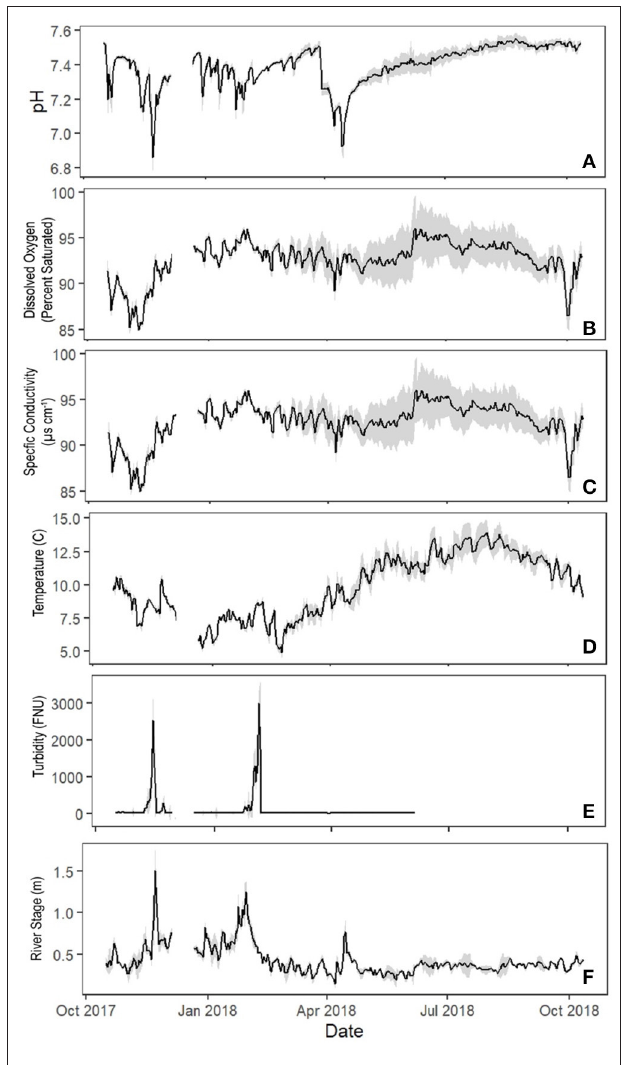
FIGURE 3 | Time series of (A) pH, (B) dissolved oxygen (percent saturated), (C) specific conductivity ( µ S cm − 1 ), (D) temperature ( ◦ C), (E) turbidity (FNU), and (F) river stage (m) over the course of the study period, October 16th, 2017 through October 12th, 2018. Blue background delineates distinct period of storm-driven parameter behavior (greater variability) over the course of the year. Measurements were taken every 5min from October 16th to December 4th, 2017, and every 15min from December 21st, 2017 to October 12th, 2018. Turbidity data above the detection range (4000 FNU) were removed, as well as turbidity data after June 15th, 2018 due to a sensor maintenance